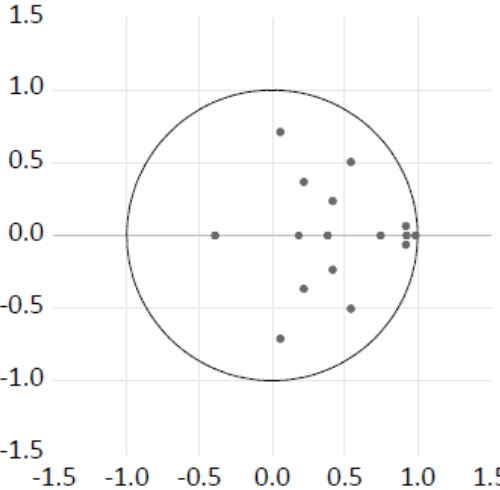
Figure 5. Inverse roots of AR characteristics polynomial plot.